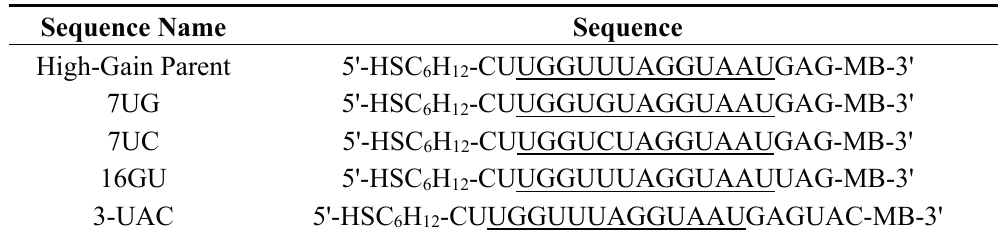
Table 1. Mutated Aminoglycoside Aptamer